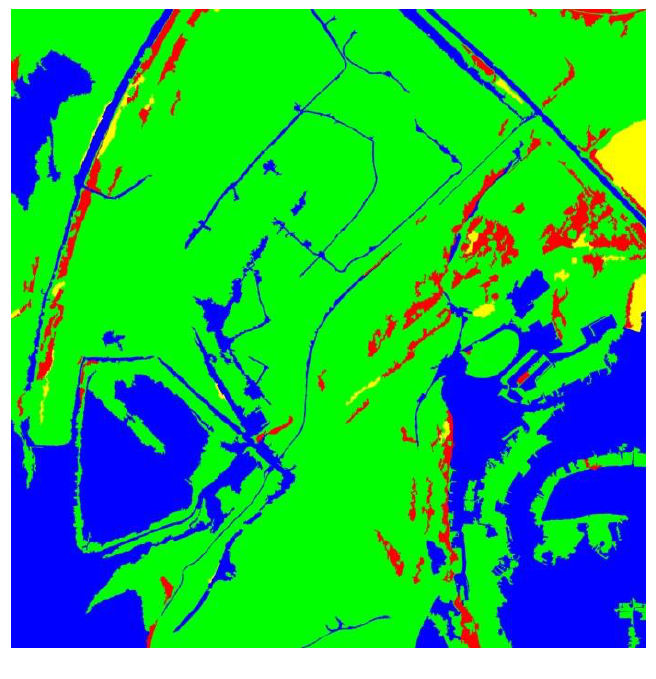
Figure 6. Output of 3rd multiresolution segmentation process (Level 3), showing ‗Knotweed Class‘